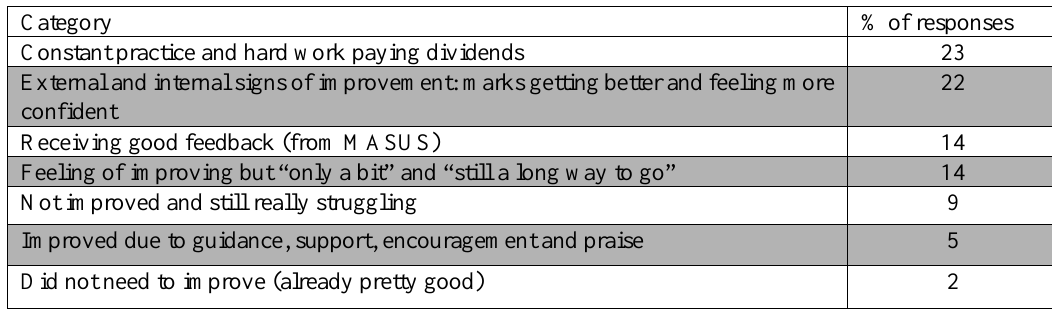
Table 3: Reason for current academic literacy self-rating (in semester 2)